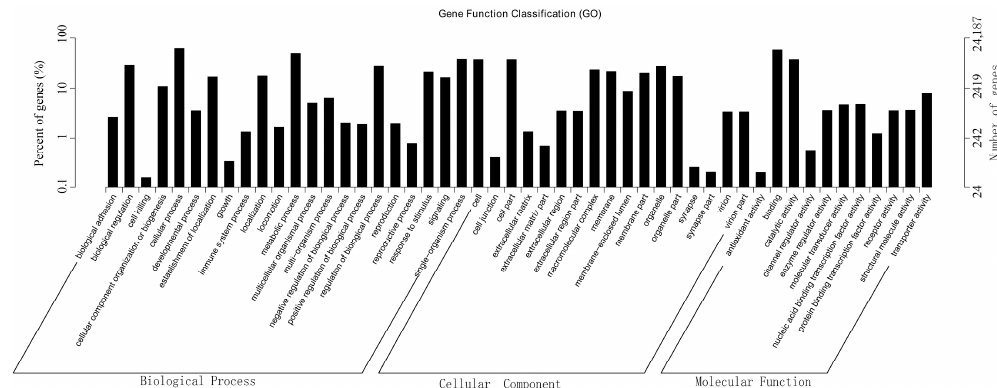
Figure 2. GO classification of assembled unigenes. X -axis, three major functional categories of GO terms: biological process, cellular component, and molecular function; Y -axis, terms with numbers/percents of unigenes in the major category.